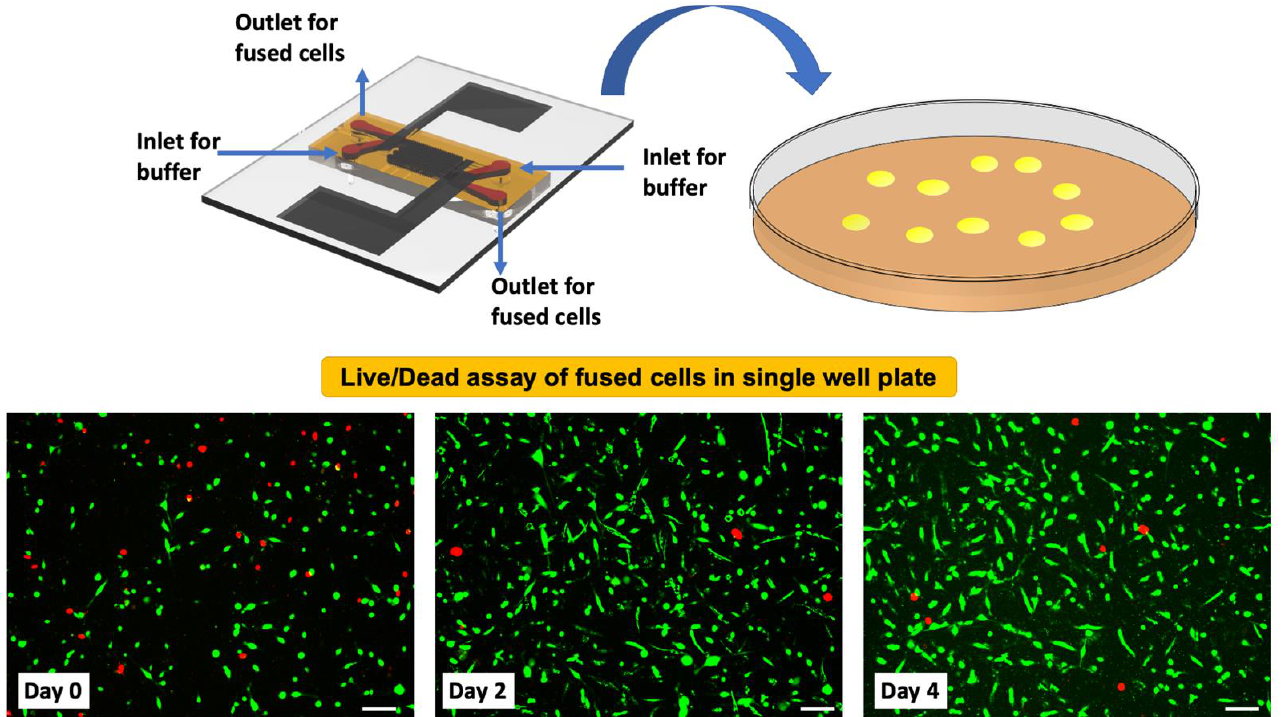
Figure 7. Live/dead assay. The fused cells were transferred from the chip to a single well plate for long-term cell culture. The cells were treated with a live/dead assay kit on day 0, day 2, and day 4, respectively. The high cell viability was observed even on day 4. This study was performed using non-fluorescence labelled cells. Scale bar: 100 µm.